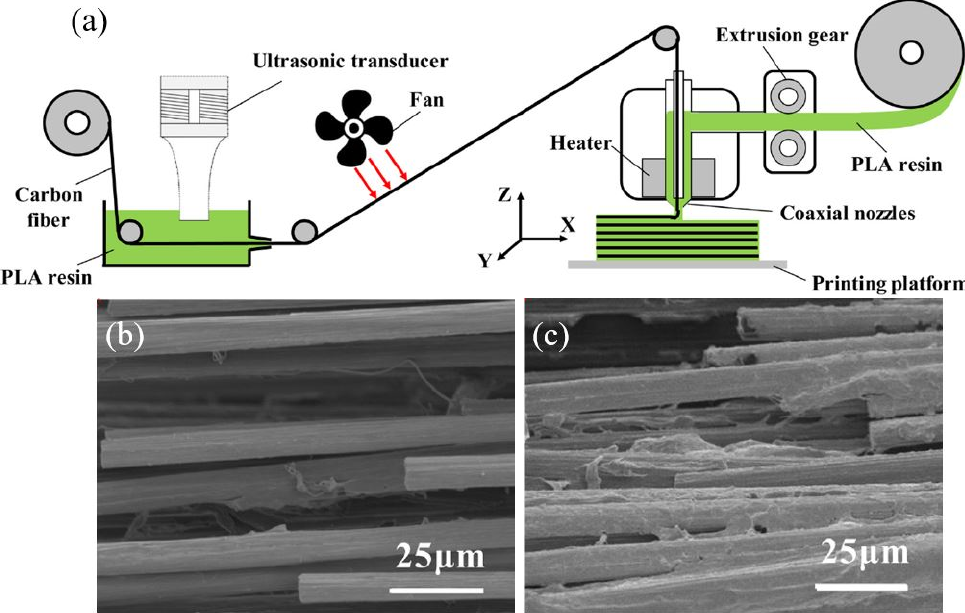
Figure 24. ( a ) Apparatus of the experiment. ( b ) Untreated CF bundle immersed in PLA resin. ( c ) Treated CF bundle immersed in PLA resin [260].